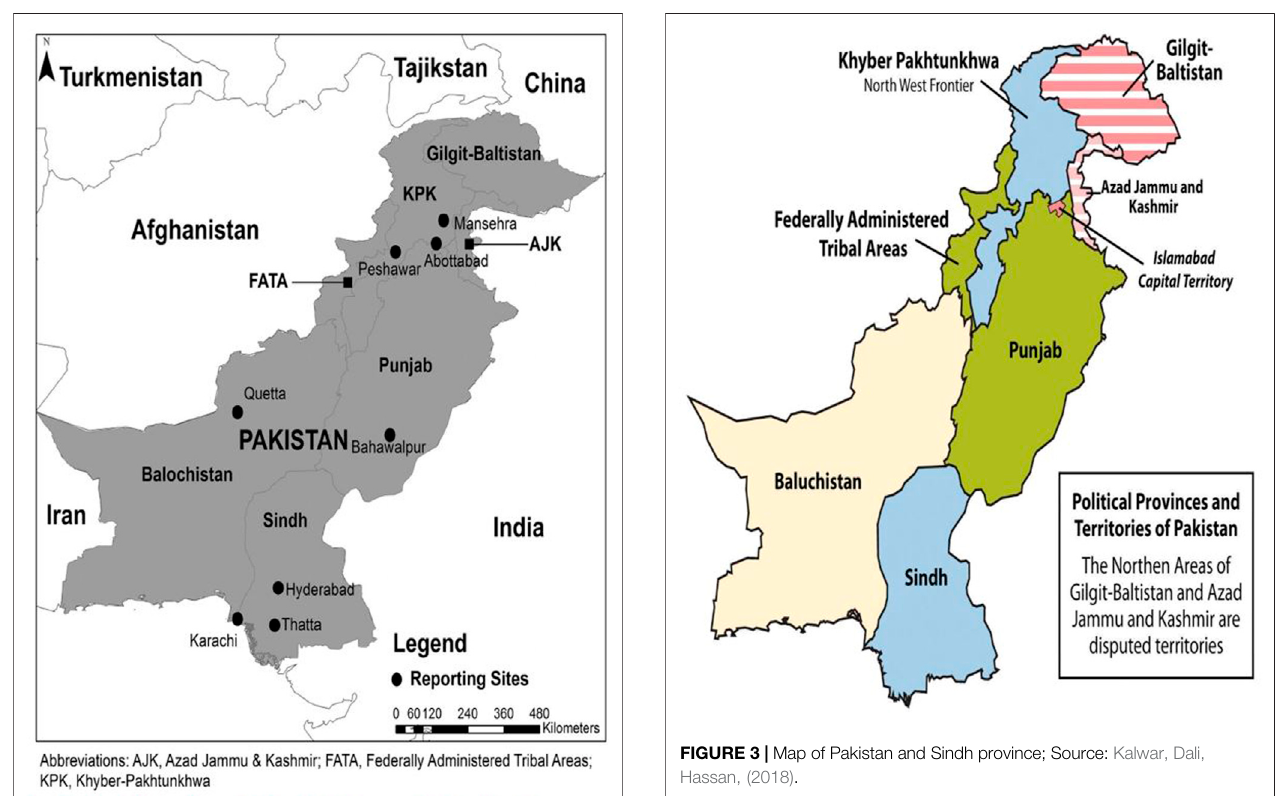
Frontiers in Built Environment |